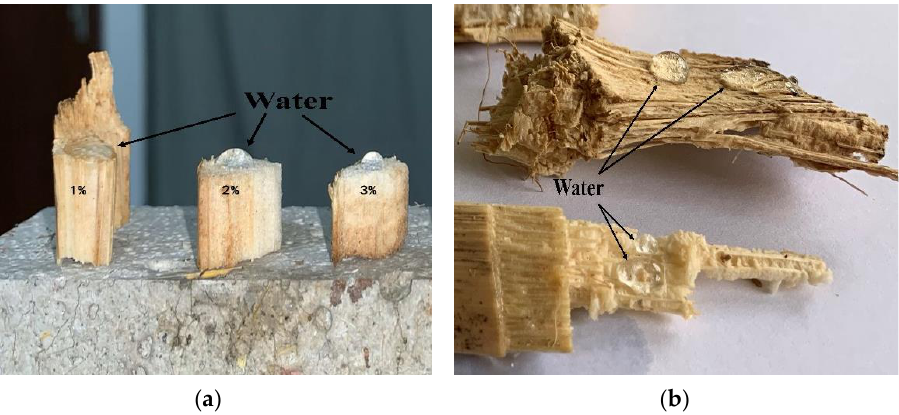
Figure 5. ( a ) Comparison of water absorption effect of corn straw from 1 wt.%~3 wt.%, ( b ) 3 wt.% content of silica solution concentration of corn straw produces hydrophobicity.